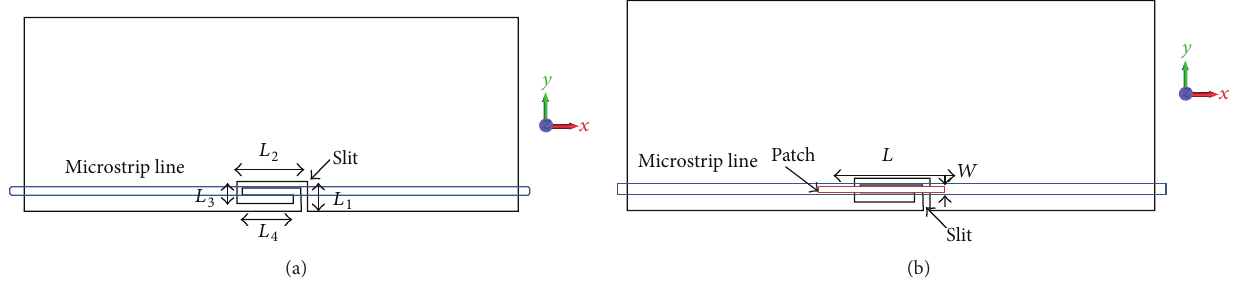
Figure 2: (a) Single convoluted slit is inserted in the ground plane. (b) Proposed convoluted double-layered structure.